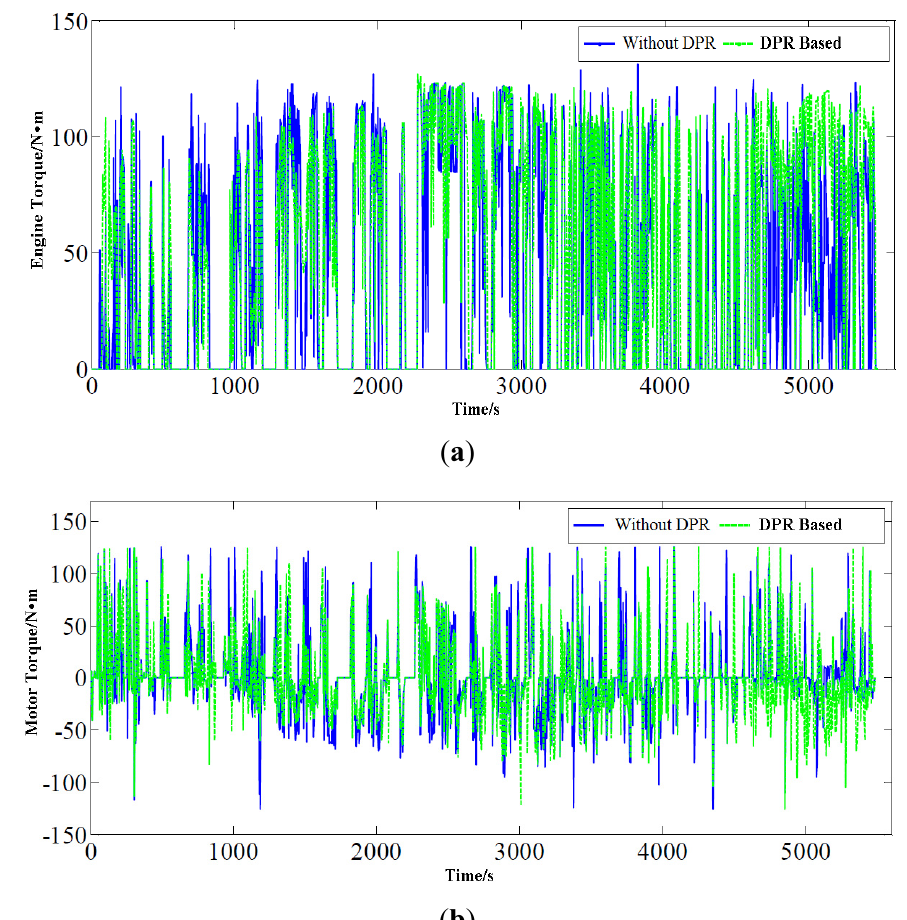
Figure 14. ( a ) Simulation results of the engine torque; ( b ) Simulation results of the motor